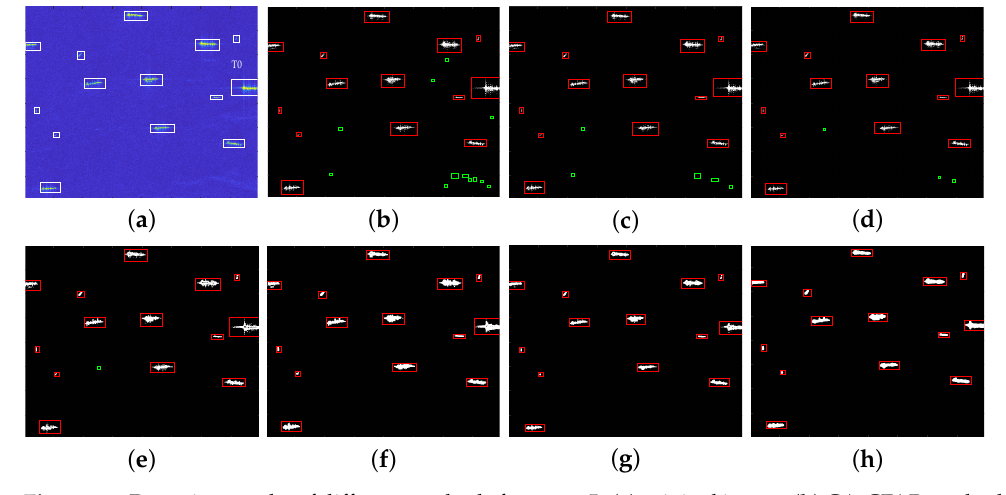
Figure 11. Detection results of different methods for scene 5. ( a ) original image; ( b ) CA-CFAR method; ( c ) G Γ D-CFAR method; ( d ) new LN-2PCFAR method; ( e ) MVWIE method; ( f ) FMPCM method; ( g ) IG method; ( h ) proposed